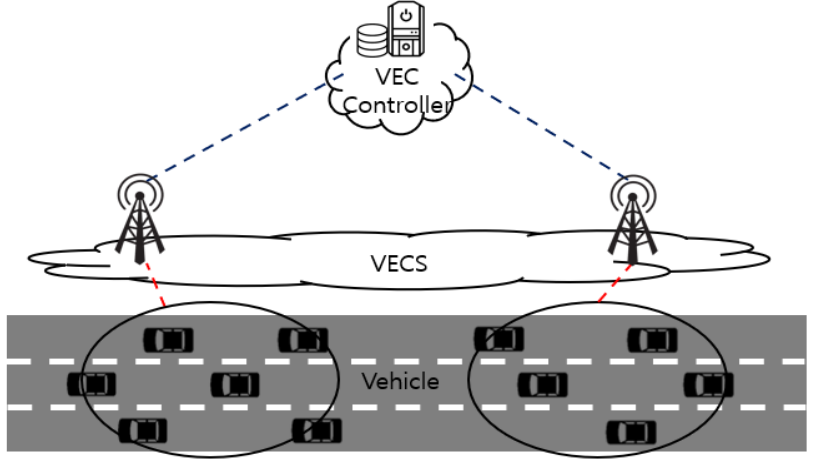
Figure 1. System